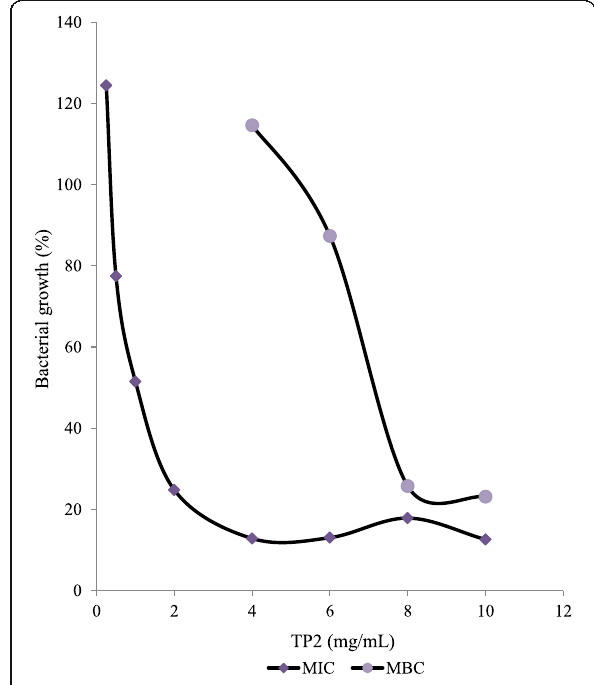
Fig. 1 Effect of TP2 extract on growth of methicillin resistant Staphylococcus aureus . Legend: TP2 is methanol extract of Madachi traditional remedy prepared from stem bark Khaya senegalensis . MIC and MBC are minimum inhibitory and minimum bactericidal concentrations